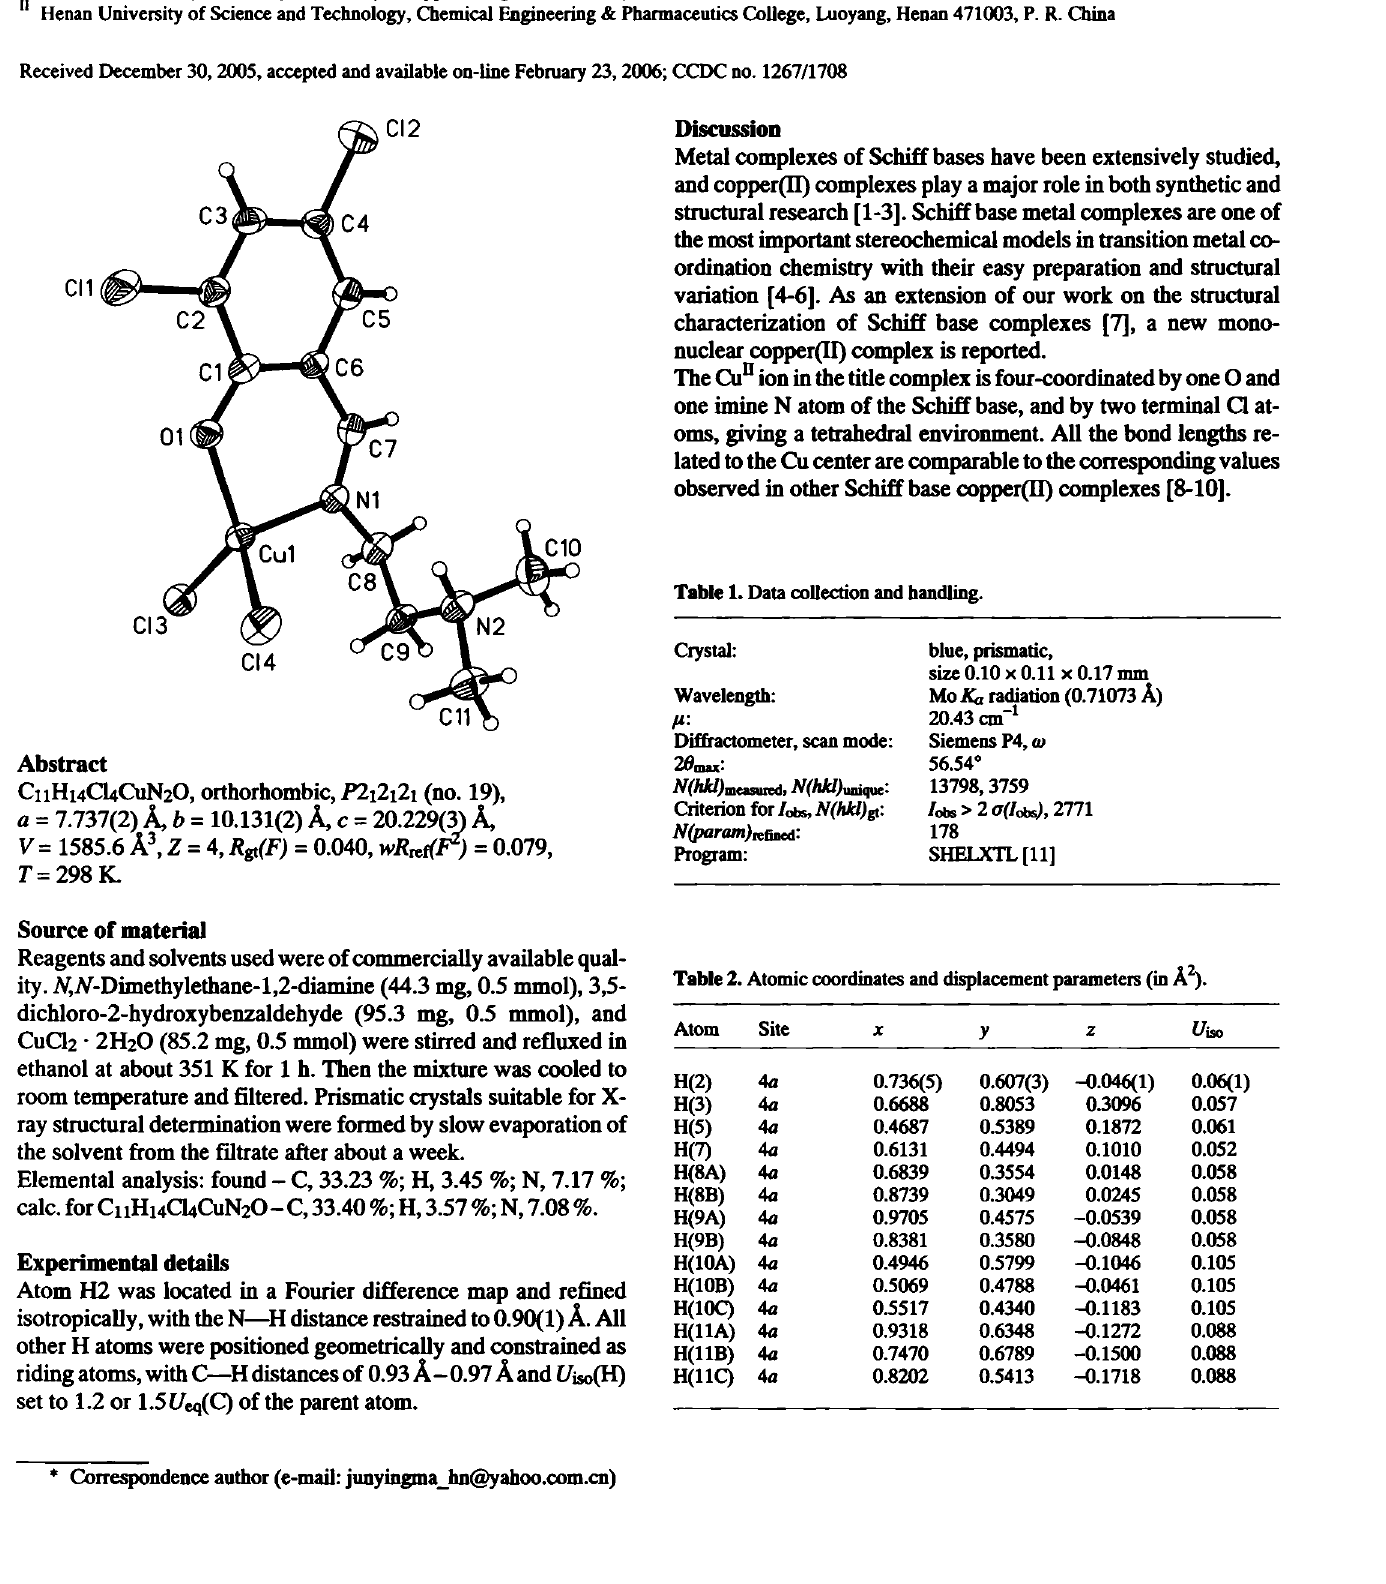
Table 1. Data collection and handling.